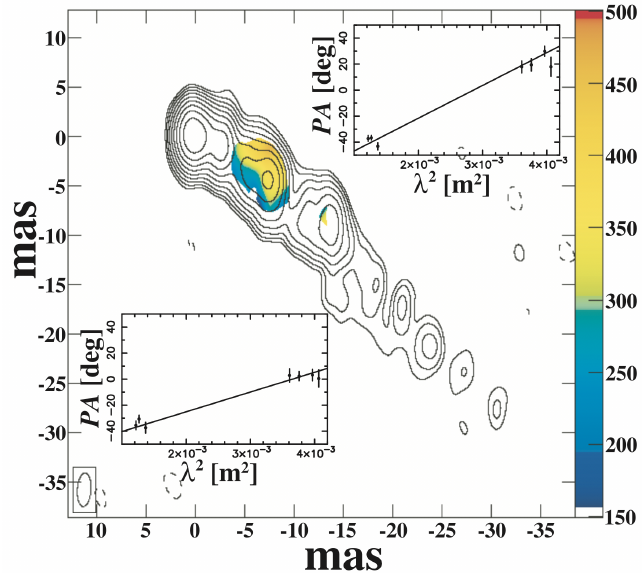
Figure 8. Colors denote the RM distribution in the 3C 273 jet observed by Asada et al. [142], while the contours represent the total intensity distribution. The inlet plots represent the EVPAs as functions of λ 2 in the two sides of the jet where the transverse RM gradient is